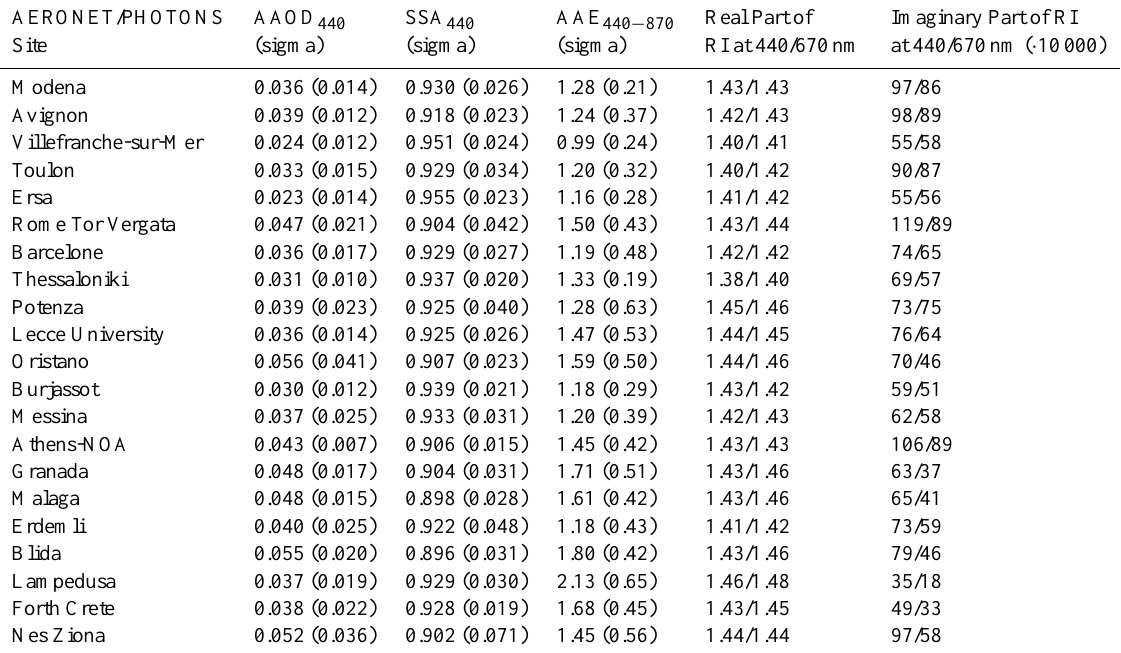
Table 2. Level-2 averaged Aerosol Absorbing Optical Depth at 440nm (AAOD 440 ), Single Scattering Albedo at 440nm (SSA 440 ), Absorb- ing Angström Exponent estimated between 440 and 870nm (AAE 440 − 870 ), real and imaginary parts of aerosol Refractive Index (RI) at 440 and 670nm, and number of days with data over the time period reported in Table 1. Standard deviations (sigma) are also reported in parentheses for AOD, SSA and